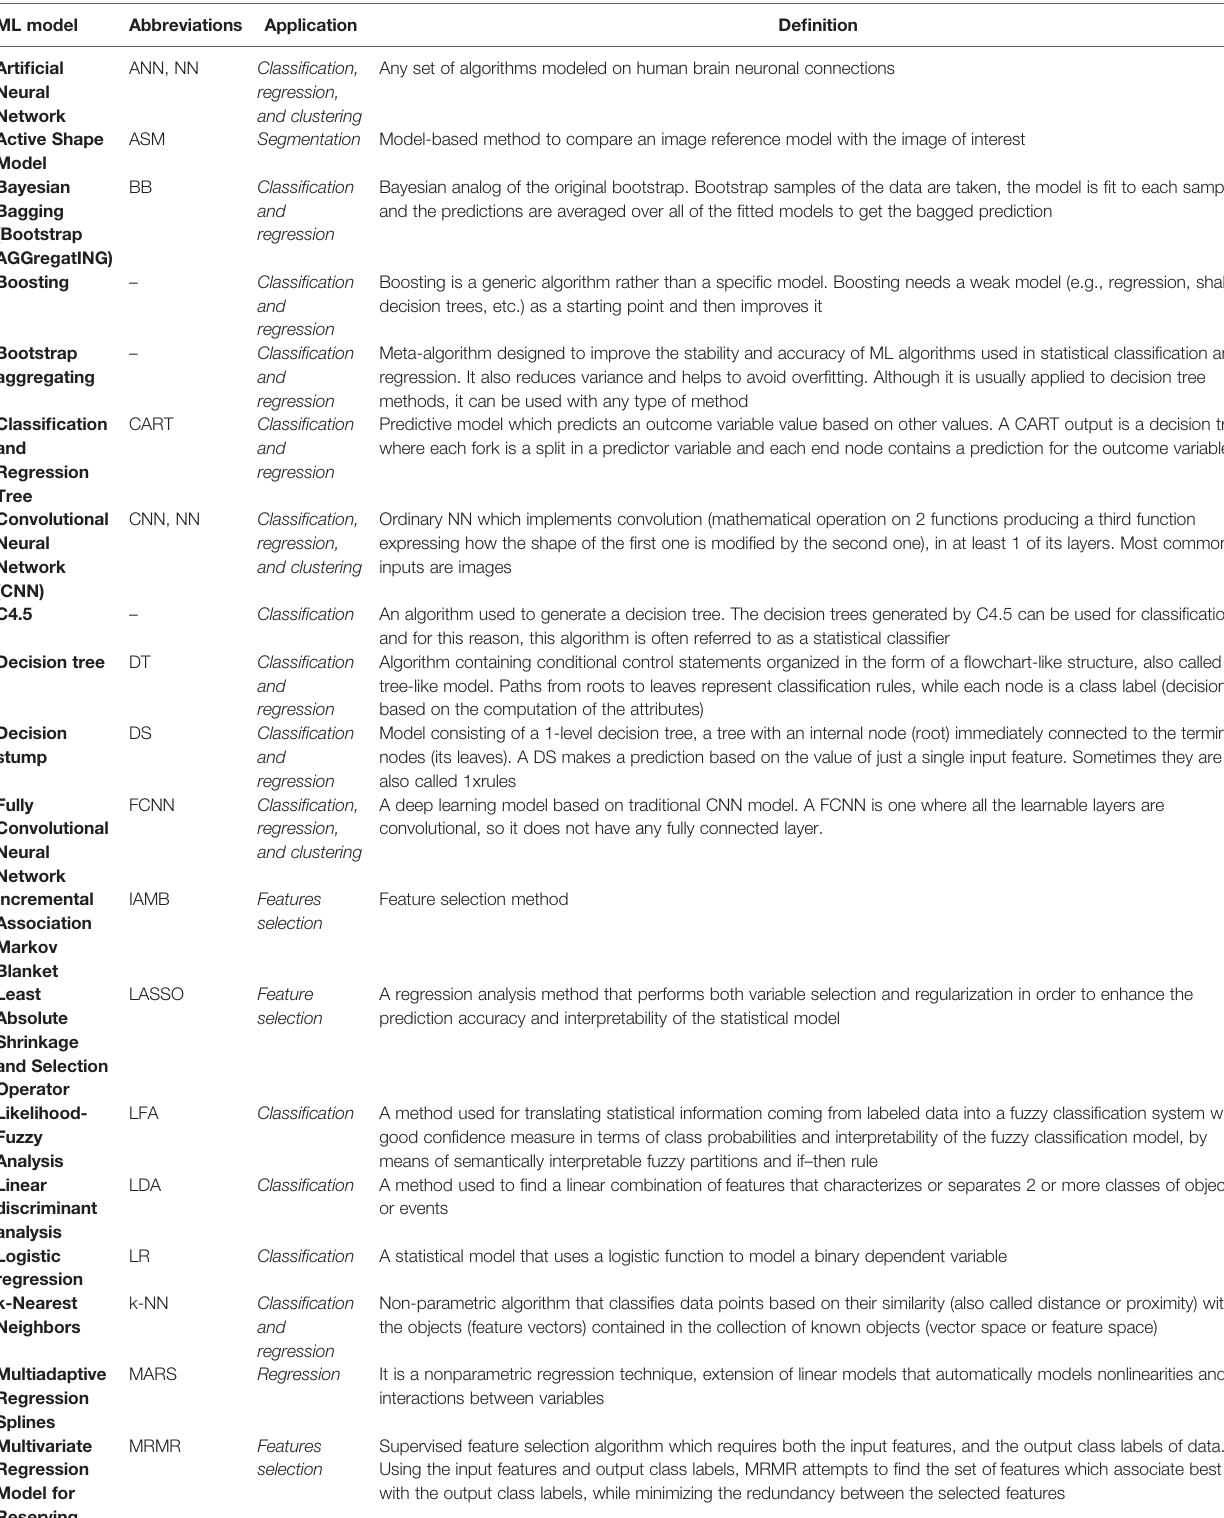
TABLE 1 | Summary and de fi nitions of most common machine learning (ML) models. ML